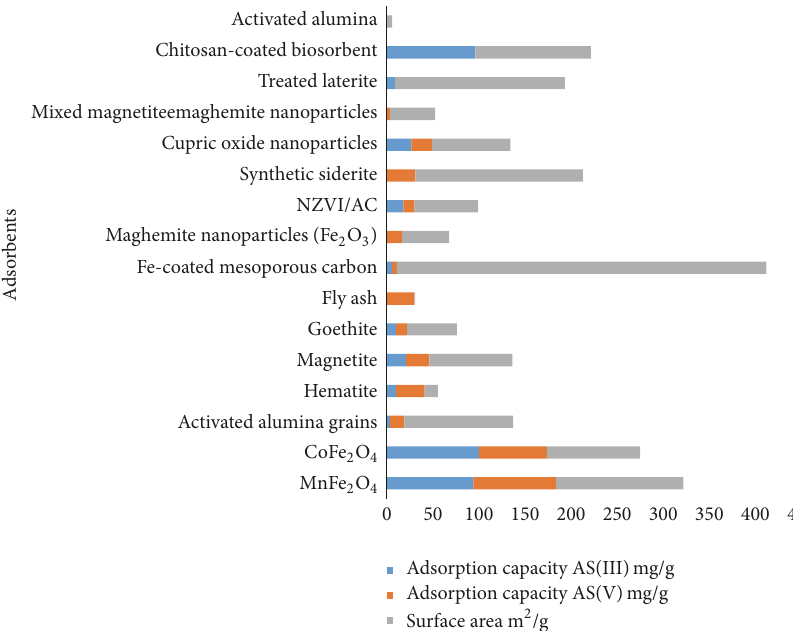
Figure 2: Adsorbents sorption capacity and surface area for arsenic